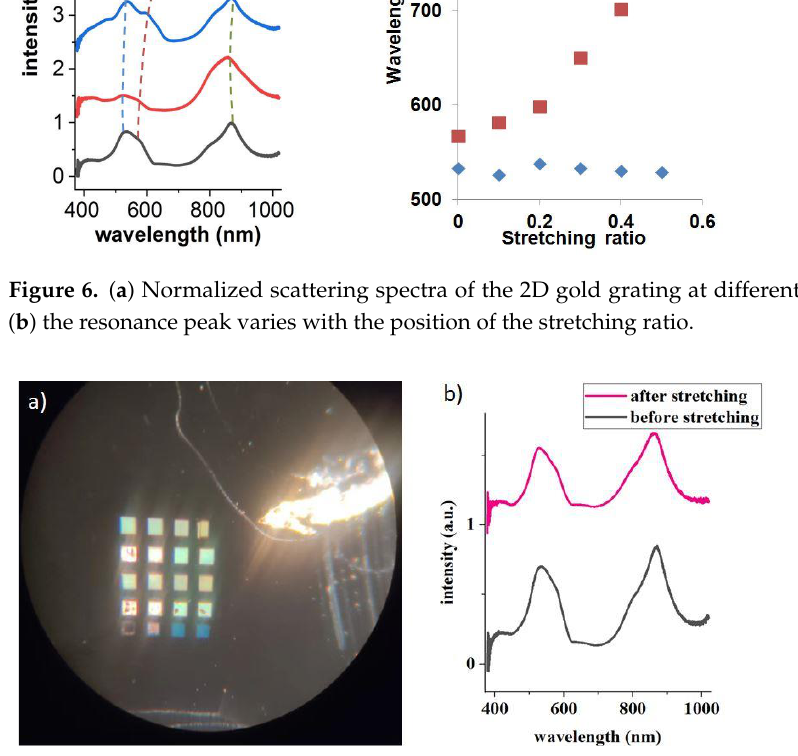
Figure 7. ( a ) dark-field microscope image of flexible 2D grating after stretching; ( b ) normalized scattering spectra of the flexible 2D gold grating before and after stretching.